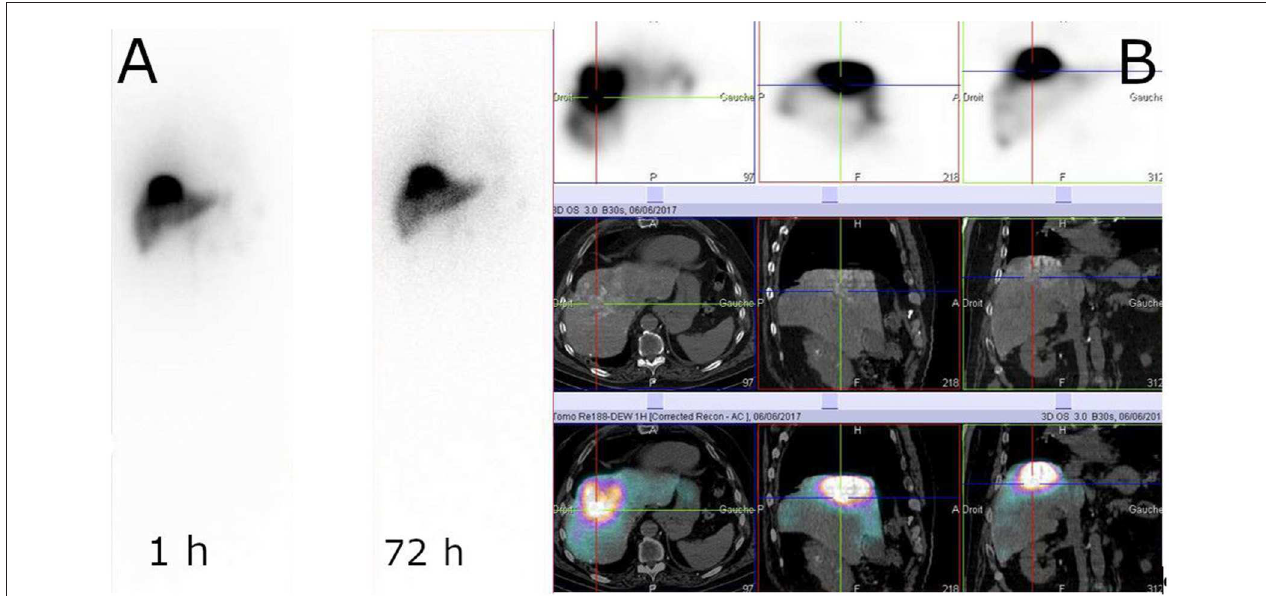
FIGURE 7 | Example of 188 Re-SSS biodistribution profile. Whole-body scintigraphy at 1 and 72h (A) and SPECT/CT at 1h (B) (Courtesy of Prof. Etienne Garin, Rennes, France).